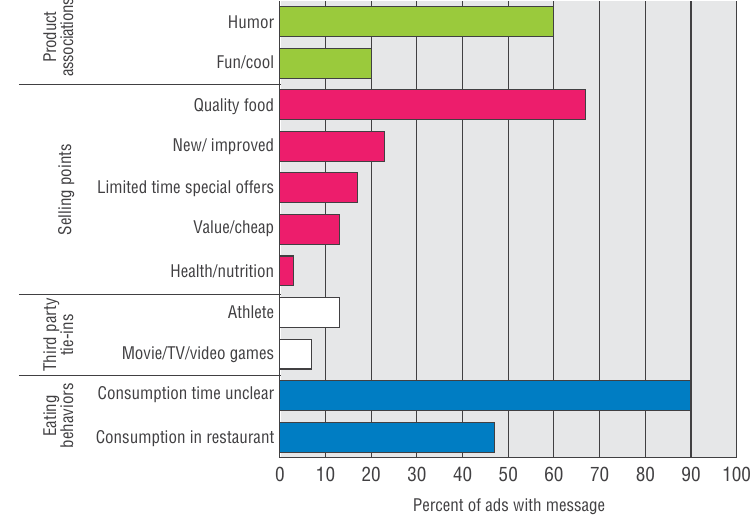
Figure 11. Messages in advertising for other products on children’s TV